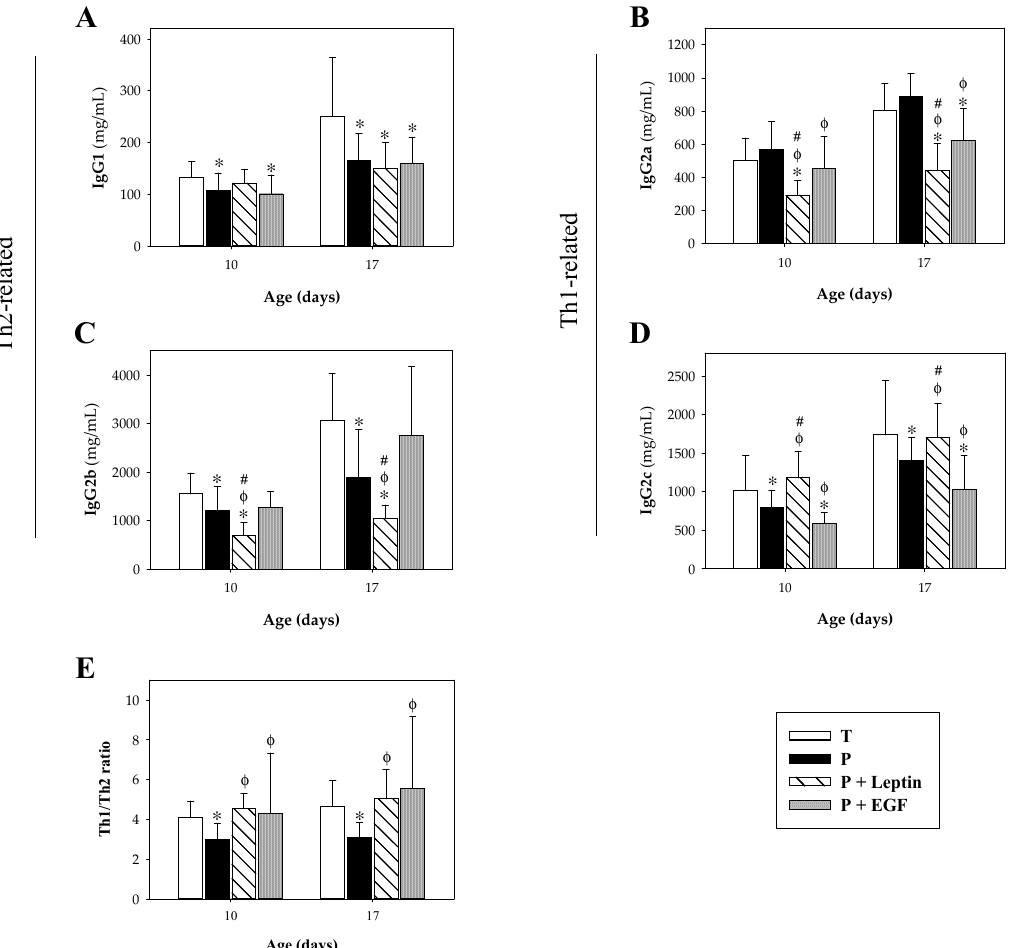
Figure 4. Plasmatic concentration of IgG subclasses at days 10 and 17. IgG1 ( A ), IgG2a ( B ), IgG2b ( C ), IgG2c ( D ), and Th1/Th2 ratios ( E ) from the four groups: Term (T), Preterm (P), P+Leptin, and P+epidermal growth factor (P+EGF) are expressed as mean ± SD ( n = 8–12 pups/group). Statistical differences: * p < 0.05 versus T group; φ p < 0.05 versus P group; # p < 0.05 versus P+EGF group.